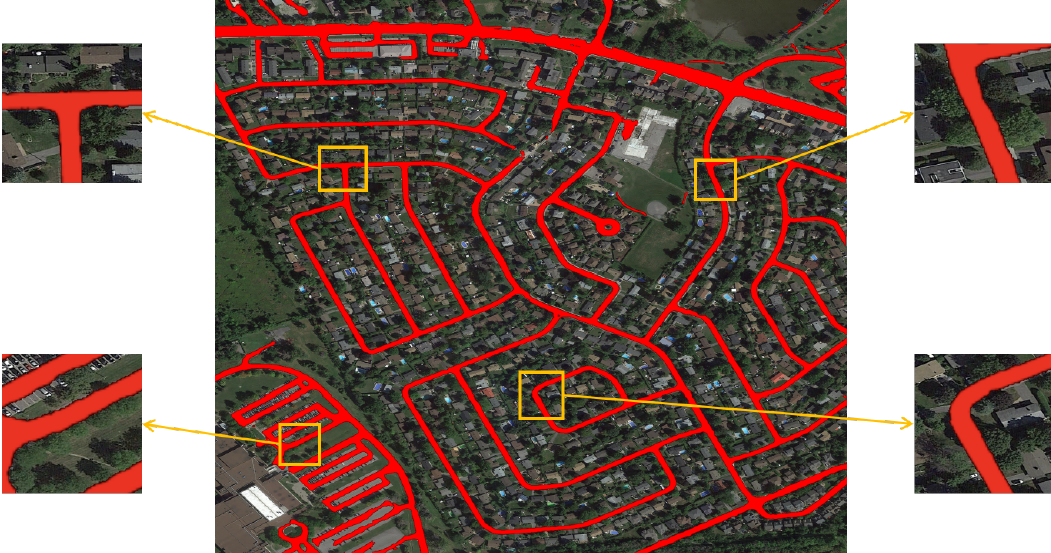
Figure 15. The visualized segmentation results of the lightweight network with an image from the RoadNet Dataset. The four images on the left and right are the enlarged renderings of the figure. Table 4. Performance comparisons of different methods on the RoadNet Dataset in terms of Road IoU, mIoU, F1 score, recall, precision, parameters, and Infer Time. The best results are shown in bold.